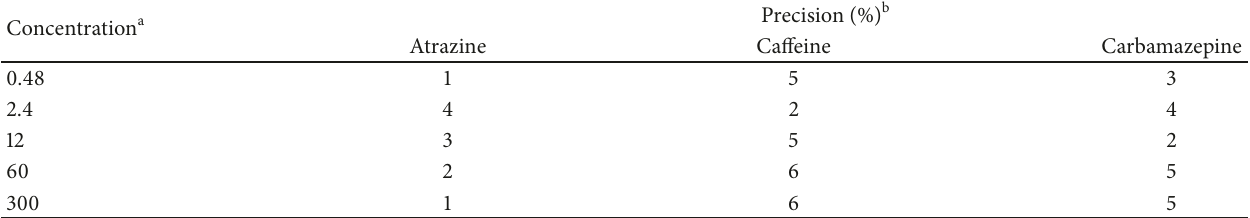
Table 4: Coefficients of variance for intraday analysis of mixed solutions of the analytes.